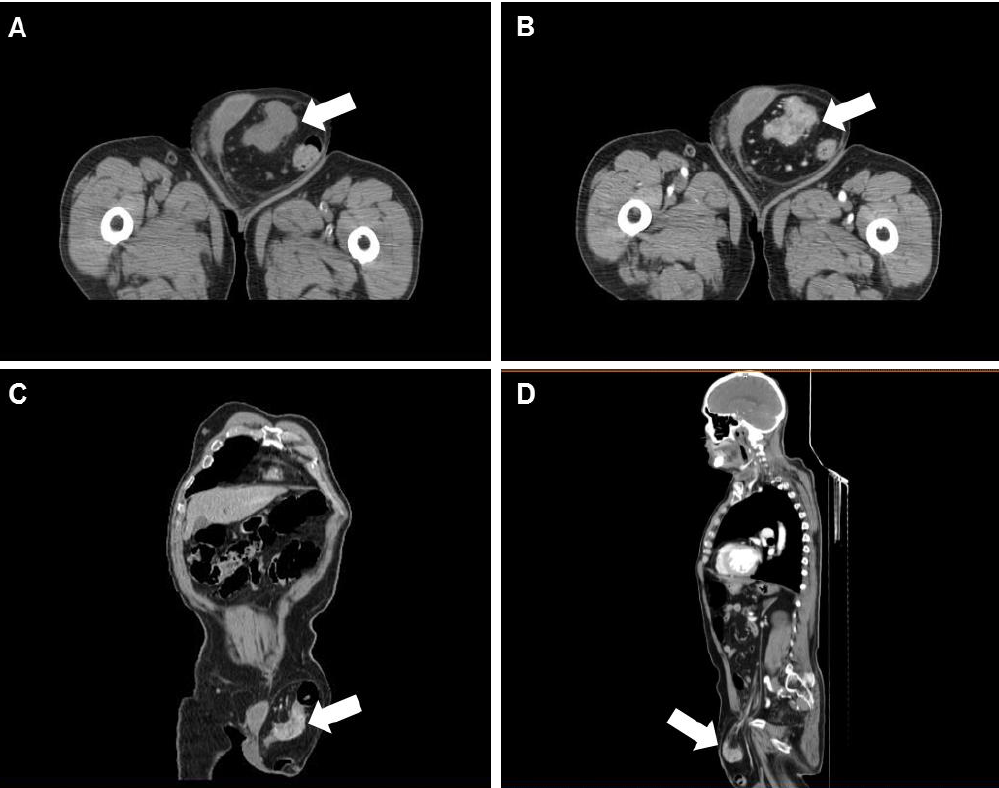
Figure 1. Computed tomography (CT) scan of sigmoid colon carcinoma incarcerated in inguinal hernia.: ( a ) axial plane without contrast injection; ( b ) axial plane with contrast enhancement; ( c ) coronal plane with contrast; ( d ) sagittal plane with contrast. Note: The arrows identify the pathological